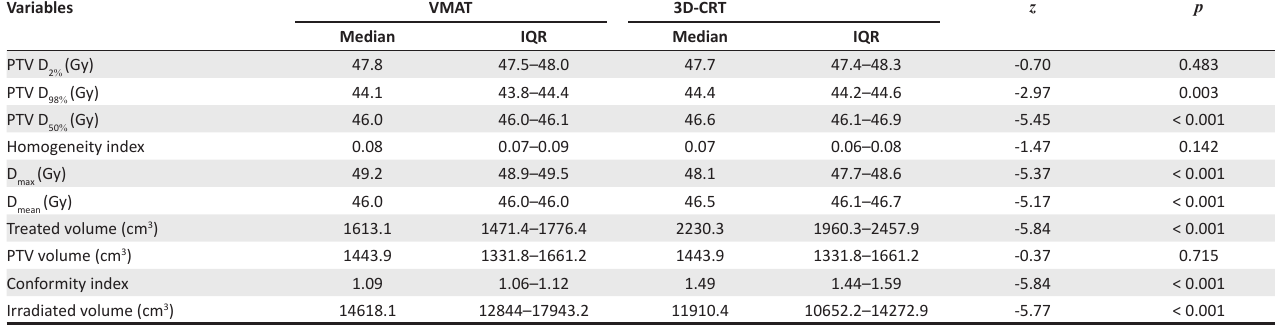
TABLE 1: Tumour dosimetric parameters for volumetric modulated arc therapy and three-dimensional conformal radiation. Variables VMAT 3D-CRT